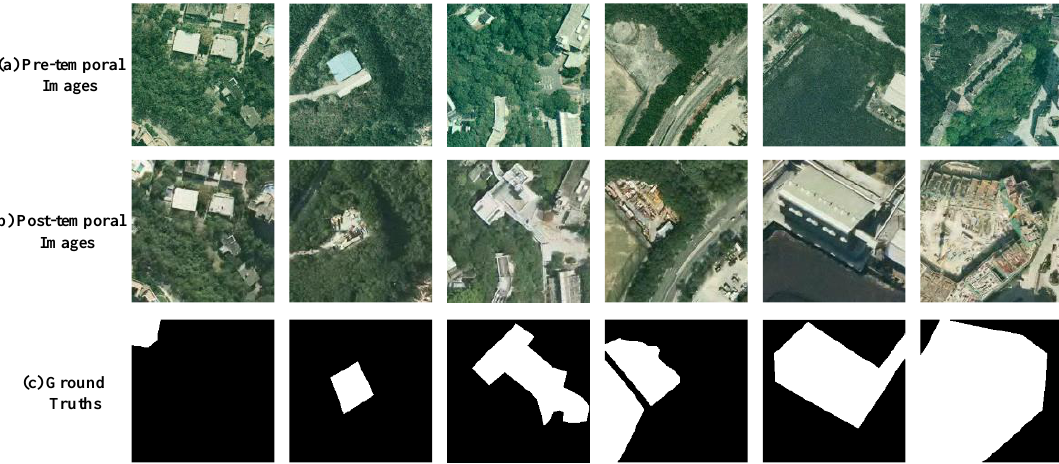
Figure 4. A demonstration of six scenarios from the SYSU-CD dataset.